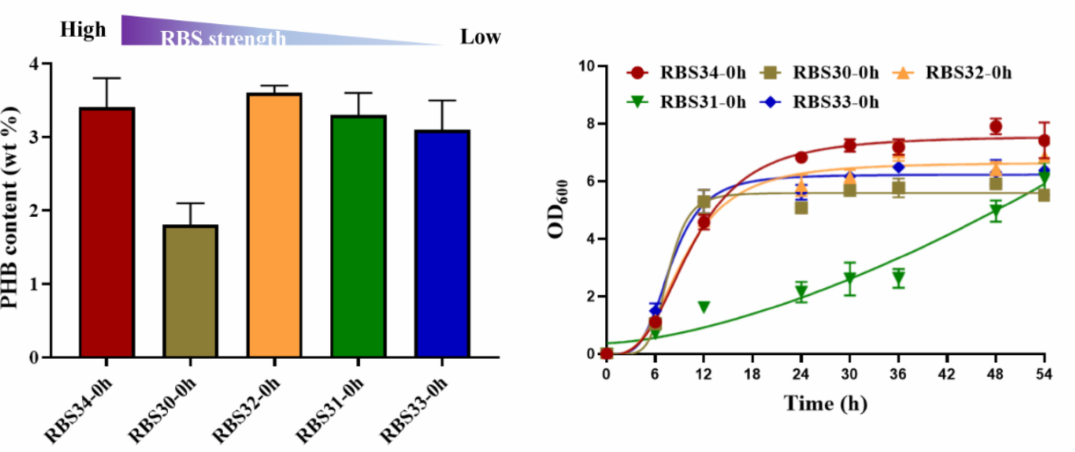
Figure 5. Regulation of gltA expression affected PHB production and cell growth. RBS strength of B0034 (1), B0030 (0.6), B0032 (0.3), B0031 (0.07), and B0033 (0.01) were applied for gltA expression